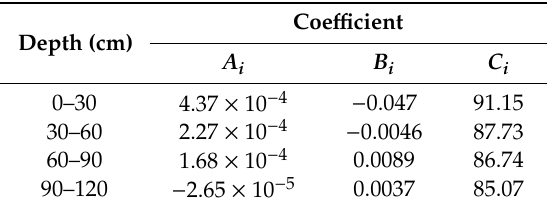
Table 3. Regression expression coe ffi